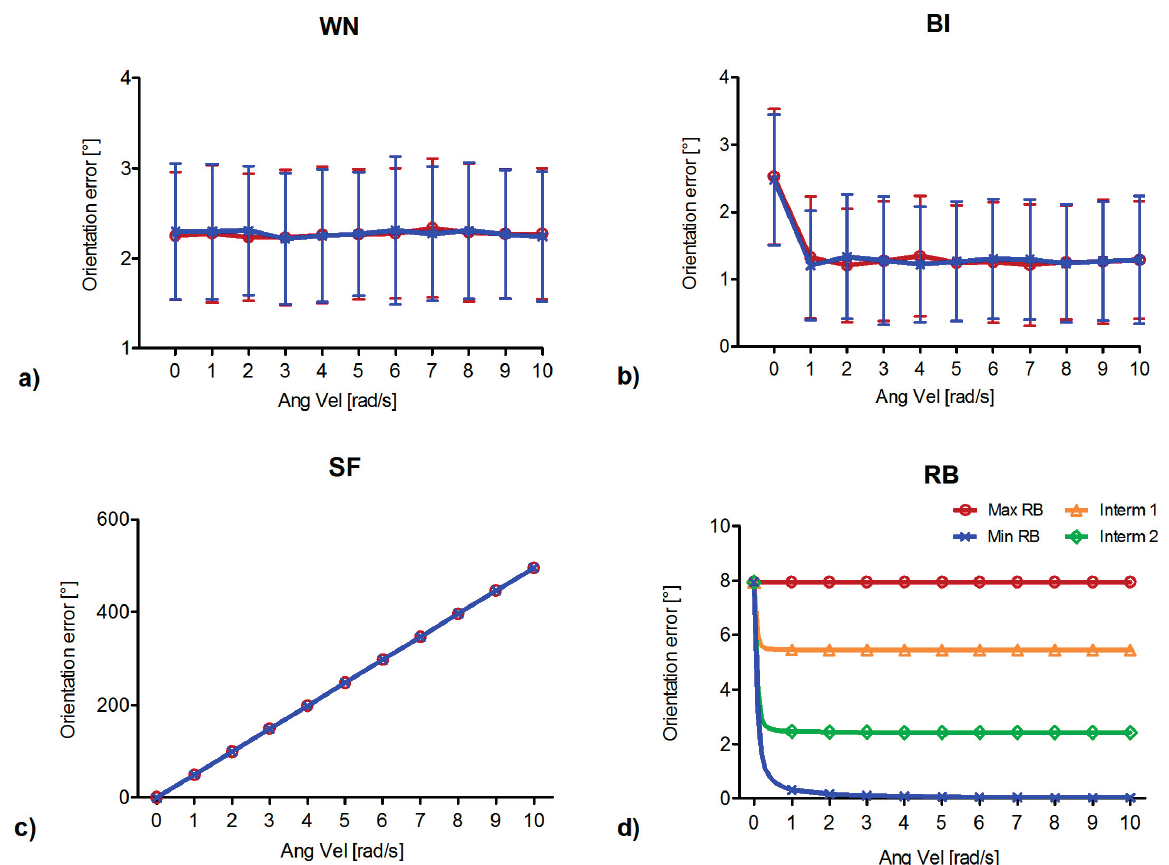
Figure 5. Orientation error associated to each homogeneously distributed noise type as a function of the magnitude of a constant angular velocity vector. ( a ) WN: white noise; ( b ) BI: bias instability; ( c ) SF: scale factor; and ( d ) RB: residual bias. Four distributions of the angular velocity vectors (maximum RB error: dark red; minimum RB error: dark blue; intermediate RB errors: yellow and green) were considered. Results for WN, BI and SF only report the directions of maximum and minimum RB error. The orientation error for WN and BI is reported as mean and standard deviation (vertical bars) corresponding to the five hundred simulation runs of each noise